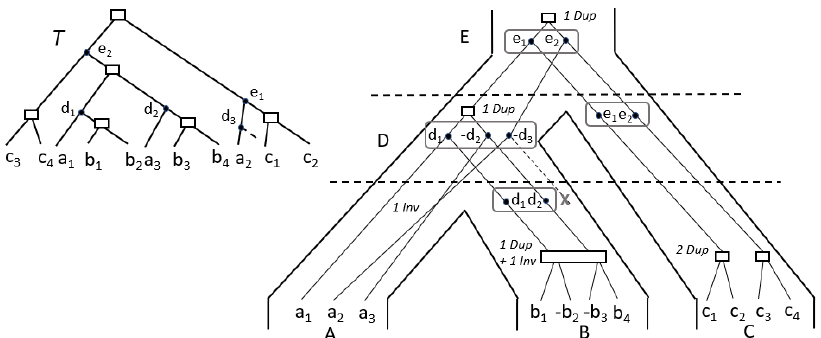
Figure 7. The gene tree T is event-labeled according to the lca-mapping with the species tree S = (( A , B ) , C ) . A leaf x i of T denotes a gene copy in genome X , its index i corresponding to its position in the TAG cluster of genome X , as illustrated on the tips of the species tree S on the